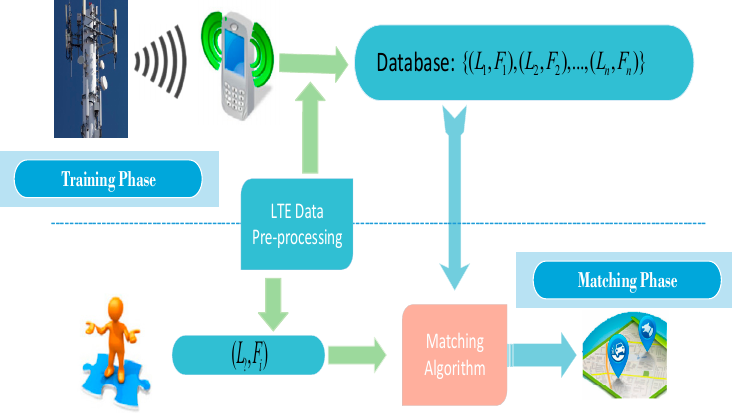
Figure 4. Illustration of proposed outdoor fingerprint-based positioning system.